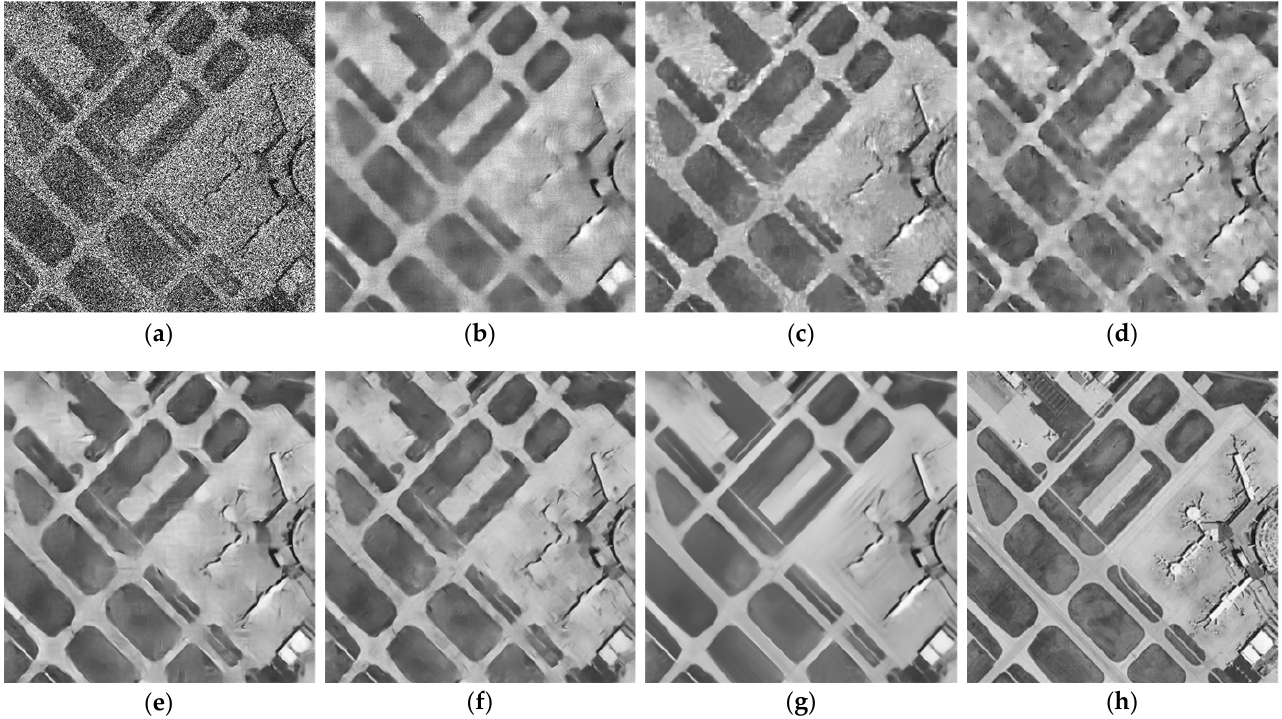
Figure 6. Despeckling results for the Airport image. ( a ) Speckled. ( b ) PPB. ( c ) SAR-BM3D. ( d ) ID-CNN. ( e ) SAR-DRN.